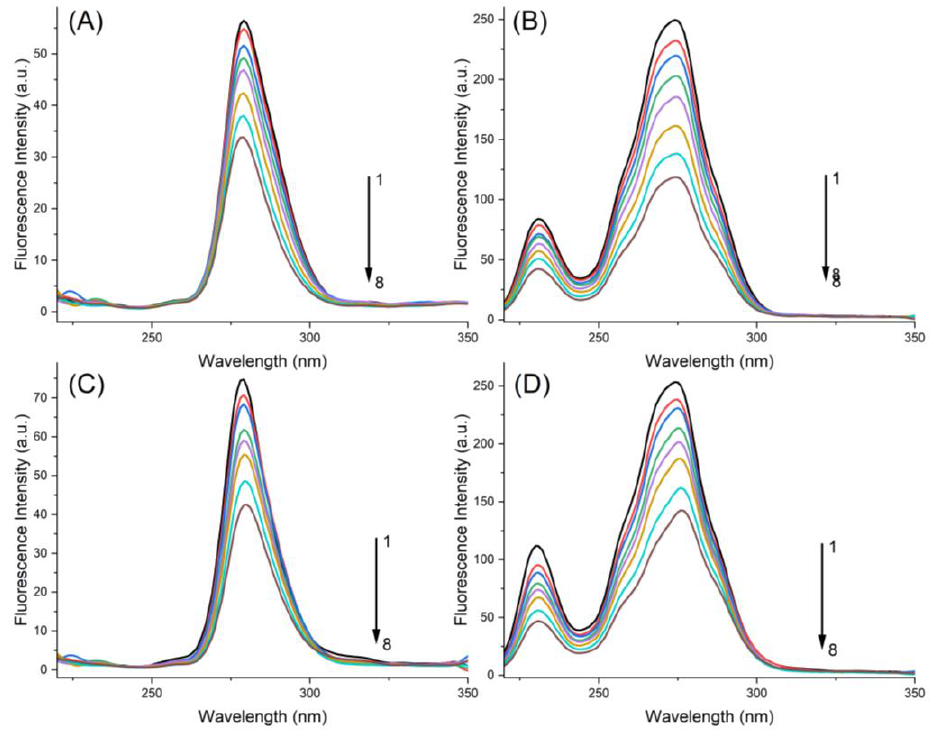
Figure 6. Synchronous fluorescence spectra of different complexes at 300 K. ( A ) PK-MYR ( ∆ λ = 15 nm), ( B ) PK-MYT ( ∆ λ = 15 nm), ( C ) PK-MYR ( ∆ λ = 60 nm), ( D ) PK-MYT ( ∆ λ = 60 nm). From 1 to 8, the concentrations of MYR and MYT are 0.0, 2.5, 5.0, 7.0, 10.0, 15.0, 20.0, and 25.0 µ M, respectively. Table 4. The Stern–Volmer equation quenching constant ( K SV ) for the site-labeling competition experiments of PK-MYR and PK-MYT